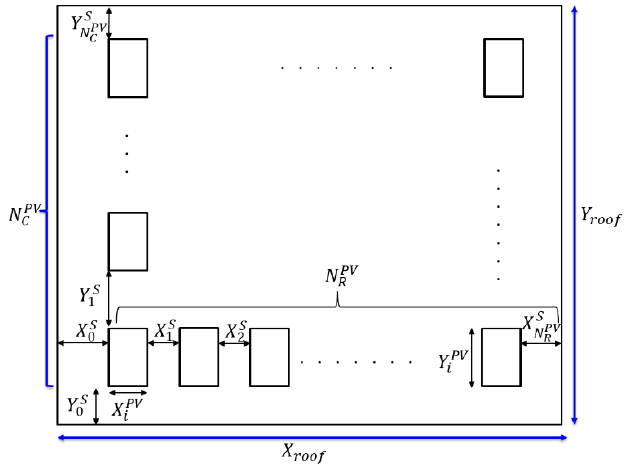
Figure A1. Example of the distribution of solar panels on the rooftop.